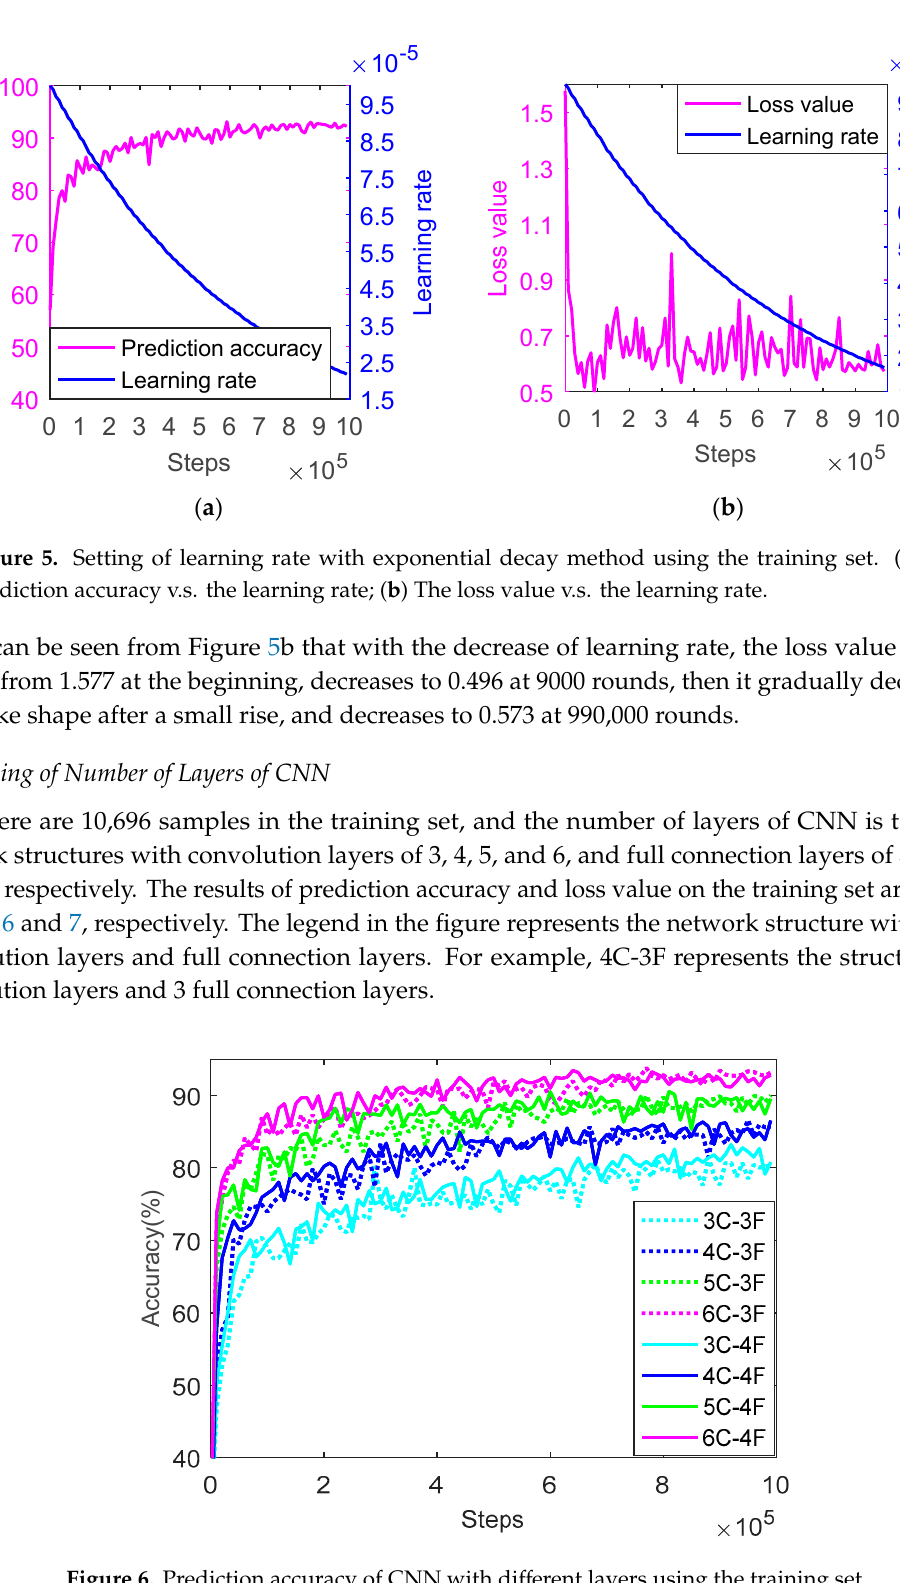
Figure 7. Loss value of CNN with different layers using the training set. It can be seen from Figure 8 that the convolutional network with three full connection layers in testing set has higher accuracy than that with four full connection layers. When the network contains 3, 4, 5, and 6 convolutional layers, respectively, corresponding to 3 full connection layers, its recognition rate is 90.35%, 91.77%, 92.75%, and 93.03%, respectively, which is 0.22%, 0.65%, and 0.66% higher than that of the corresponding convolutional network with 4 full connection layers. The convolutional network achieves the highest recognition rate of 93.03% when contains 6 convolution layers and 3 full connection layers for the testing set. The validation results using the testing set show that the network achieves the highest prediction accuracy and the lowest loss value when contains 6 convolution layers and 3 full connection layers, respectively. The prediction performance decreases when the number of full connection layers increases, which may lie in that the input is one-dimensional data with limited features, six convolution layers and three full connection layers are enough to extract all features from the input data, and any more layers will lead to overfitting.